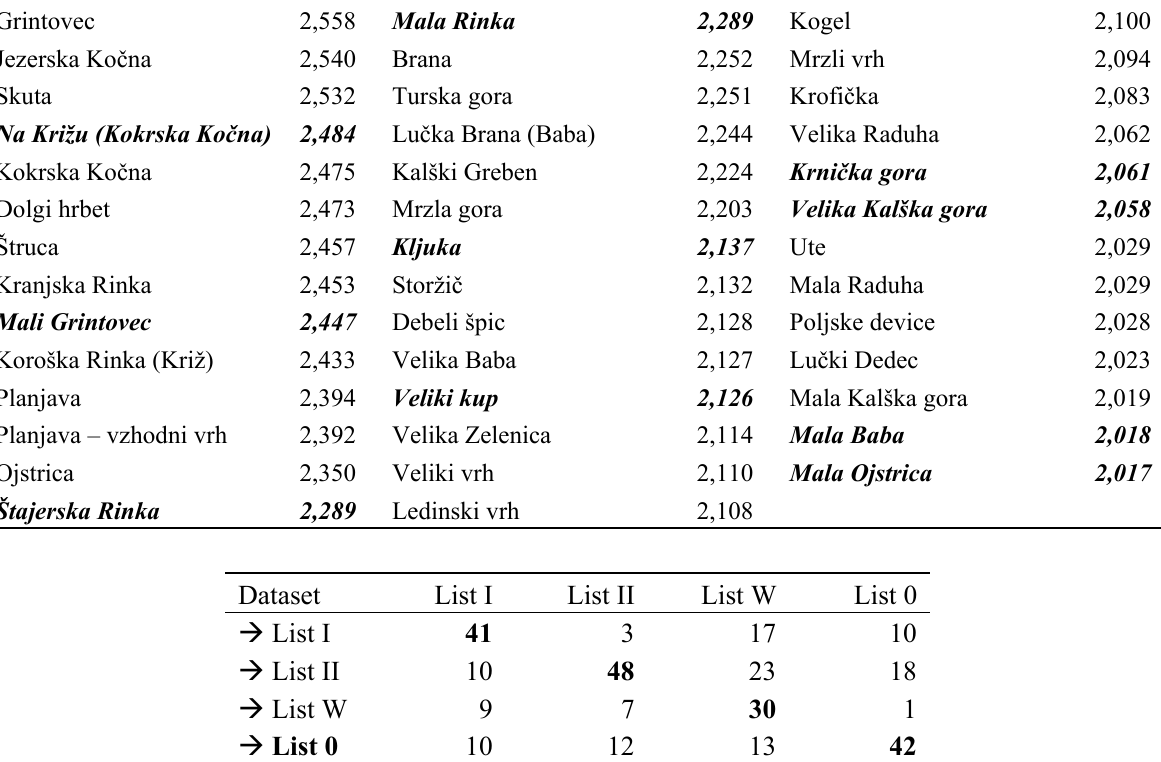
Table 6. Upper: List I of 41 peaks (described with names and heights in meters) over 2,000 m (a.s.l.) [38] in the case study area. Peaks highlighted in bold italic letters do not feature in our results, i.e. , the List 0. Below: The correlation between the Lists I, II, W and 0. The arrows indicate the direction to read the